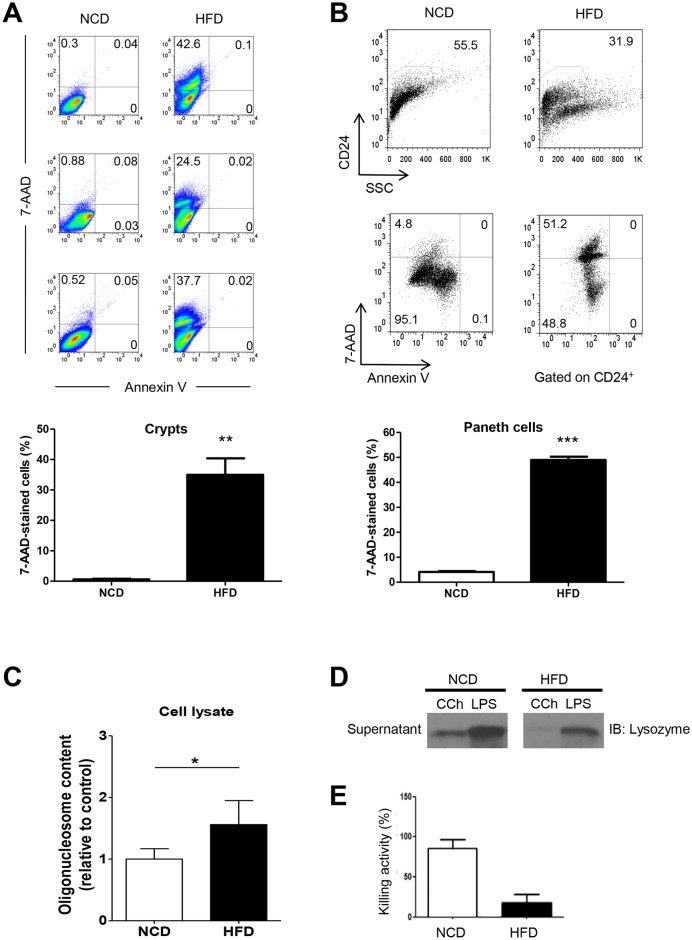
Paneth cell death and impaired Paneth cell function in mice fed a high-fat diet (HFD).(A) Crypt cell death in vivo. Crypts isolated from mice fed a normal chow diet (NCD) or a HFD were dissociated into single cells and stained using the Annexin V-FITC Apoptosis Detection Kit for flow cytometric analysis of cell death (upper panel). The percentage of 7-ADD-stained cells was compared between groups (lower panel). (B) CD24+ Paneth cell death in HFD-fed mice. Isolated crypts were dissociated into single cell suspensions, and CD24+ Paneth cell death was determined using an Annexin V-FITC Apoptosis Detection Kit for flow cytometric analysis of cell death gated on CD24 (upper panel). The percentage of 7-ADD-stained cells among CD24+ Paneth cells was compared between groups (lower panel). (C) Crypt cell death ex vivo. Crypts isolated from NCD-or HFD-fed mice were cultured ex vivo for 18 h, and DNA oligonucleosome contents in the cell lysate were measured (n = 3). (D) Crypts were stimulated with carbachol (CCh) for 30 min, and the supernatants were subjected to an immunoblot (IB) assay using anti-lysozyme Ab. (E) Bactericidal activity of intestinal crypt supernatant against Salmonella typhimurium. Data are expressed as the percentage of killed bacteria relative to unexposed bacteria (n = 3 each). All values are expressed as the means ± SEM. A student’s t-test was used to compare values between two groups. *P < 0.05, **P < 0.01, ***P < 0.001.